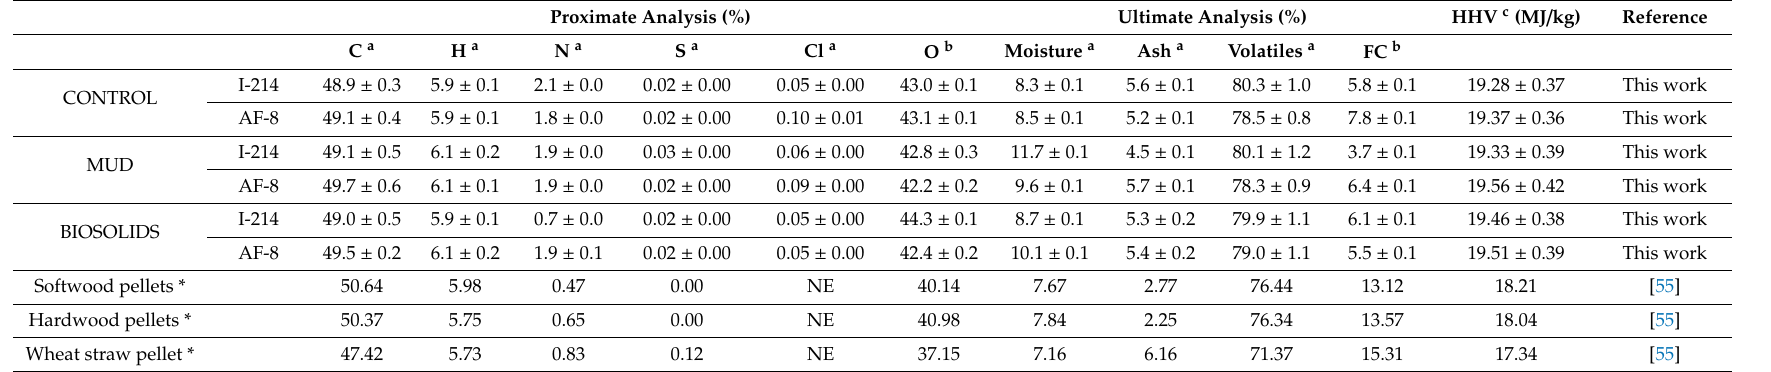
Table 2. Pellet fuel